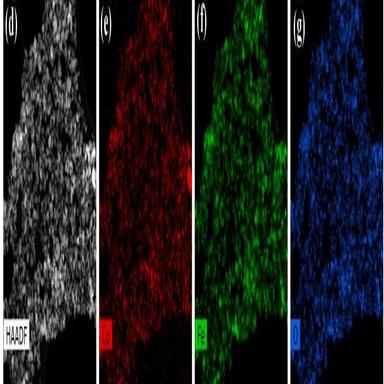
HR-TEM (a–c) and HR-TEM/EDS (d–g) images of CuFe2O4. (A colour version of this figure can be viewed online.)